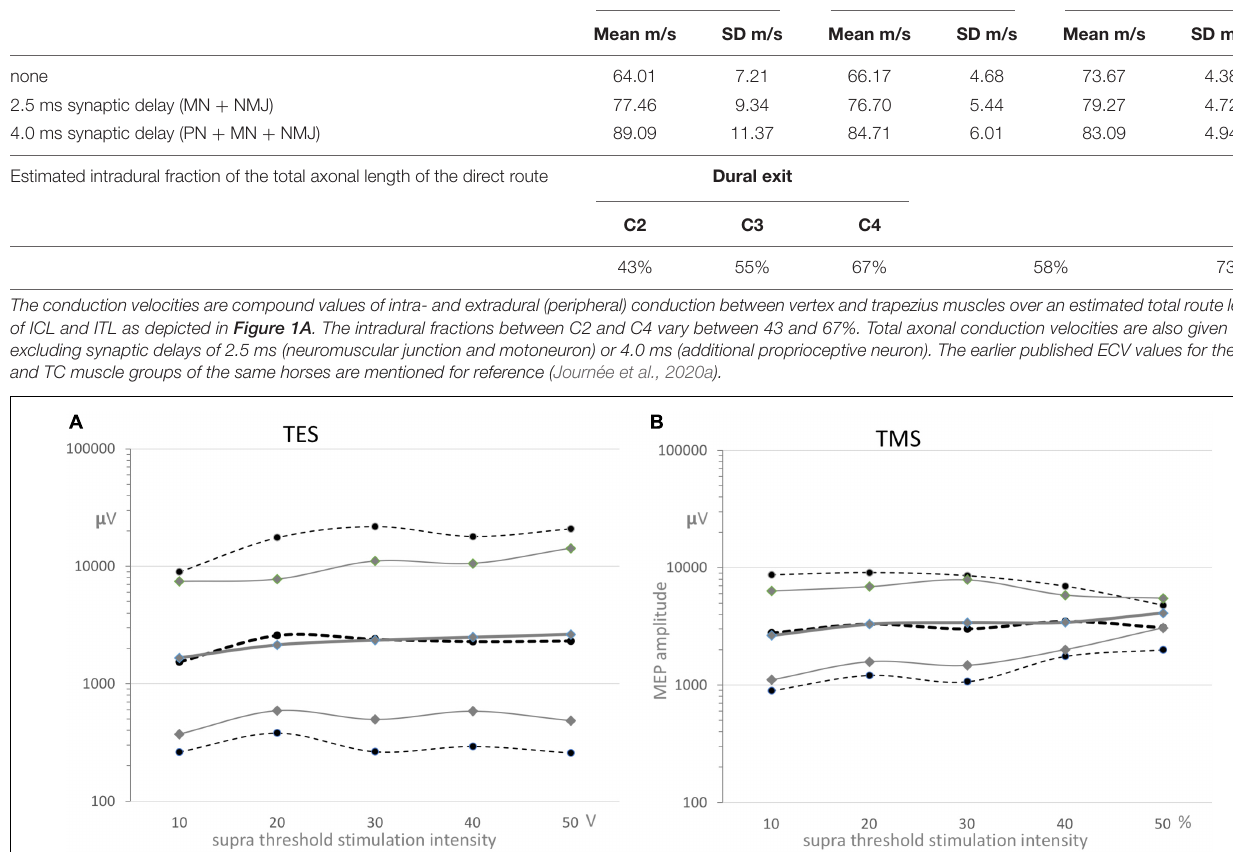
TABLE 4 | Overview of the mean and standard deviations (SD) of the overall (compound) motor conduction velocities for TES (ECV) across 12 cases comprising TES-MEP latency times EL of both sides with estimated fractions of the intradural length of the total axonal length of the direct route. Trans-synaptic exclusion